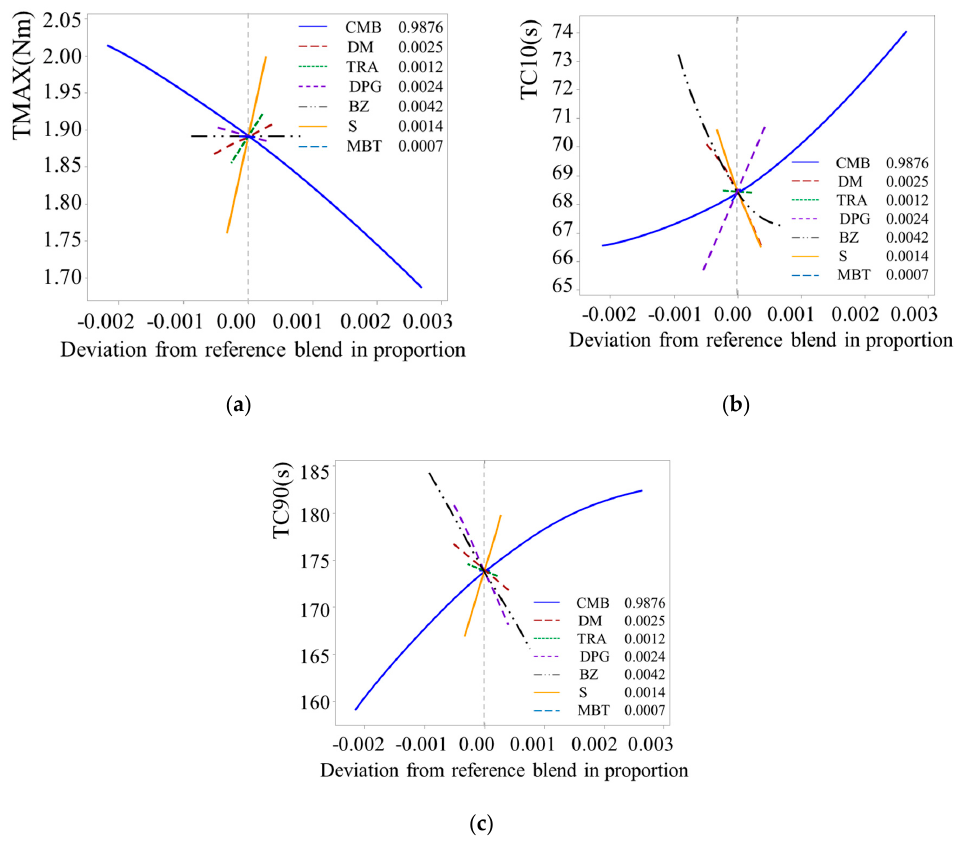
Figure 2. Cox response trace plots of vulcanization characteristics as a function of mixing ratio: ( a ) T MAX; ( b ) TC 10; ( c ) TC